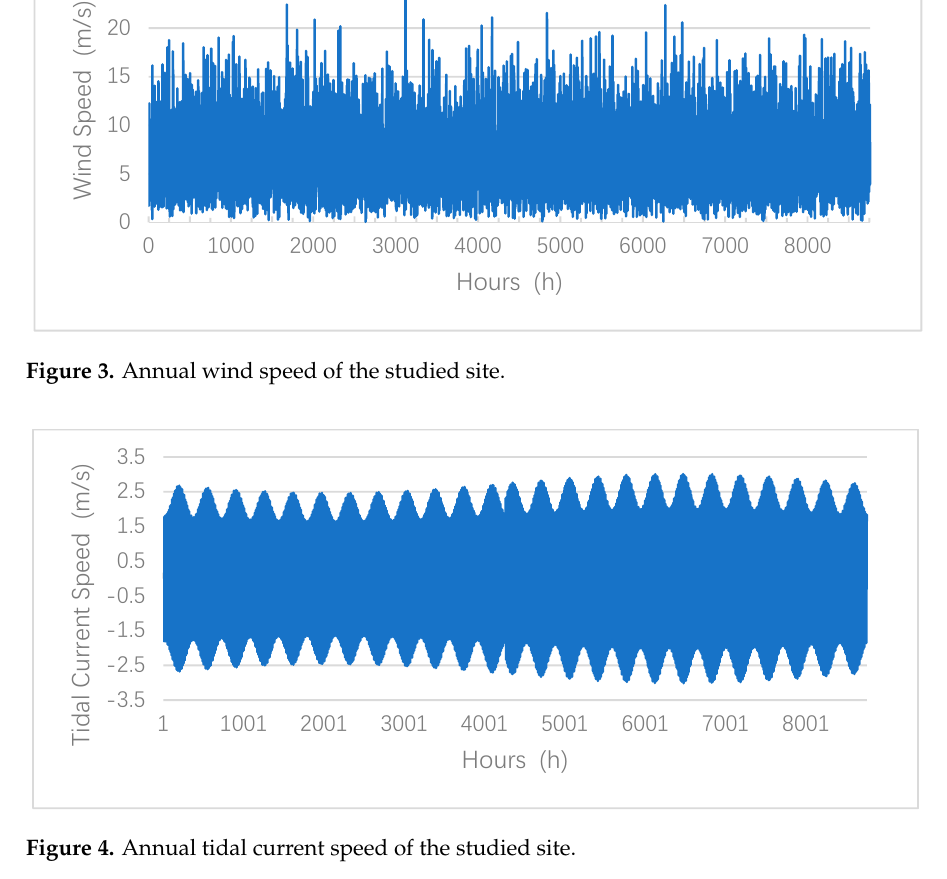
Figure 2. The map of the studied site in Zhoushan Archipelago.